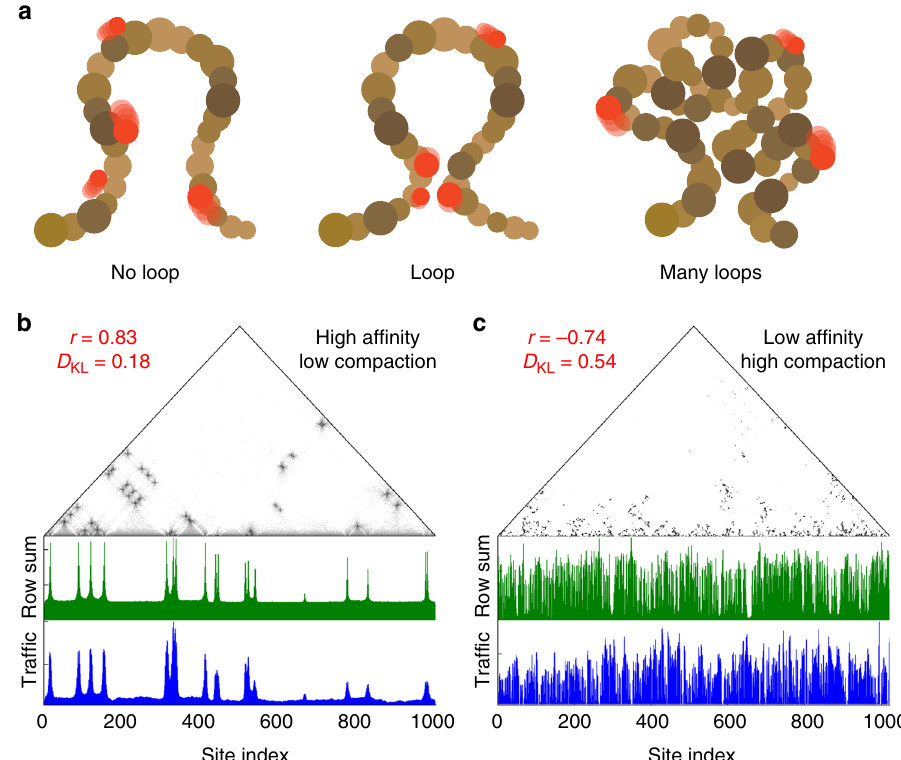
Fig. 2 The dual role of looping on transcription factor traf fi c. a Effect of chromosome conformation on the traf fi c of transcription factors. At low compaction (left), transcription factors (red) slide uniformly on the chromatin fi ber (brown). In the presence of a loop (middle), transcription factors accumulate at the contact point. When the number of loops is high (right), transcription factors diffuse on the outer shell of the globule due to volume exclusion effects. b , c Examples of simulation results with the smallest and largest values of ϕ and ε in cross combinations. For each example, we show the contact matrix of the polymer in log scale, above the traf fi c of the tracers and the total amount of contacts for each monomer (Row sum). Each plot indicates the values of the Pearson correlation coef fi cient r between the two, along with their Kullback – Leibler divergence (see text). Panel b shows a simulation with low polymer compaction and high tracer af fi nity, resulting in a strong correlation between the polymer contacts and the tracer traf fi c. Panel c shows that the opposite happens with a low tracer af fi nity and high polymer